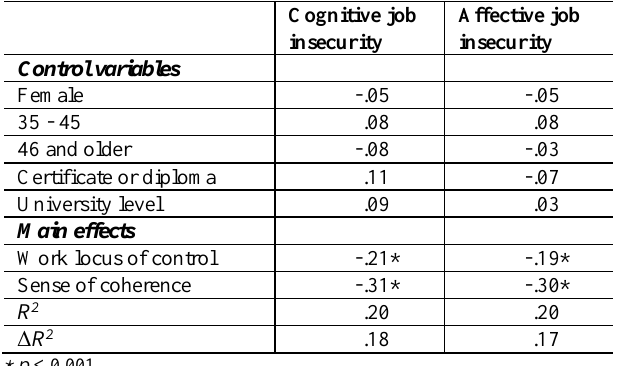
Table 3: Regression analyses with cognitive and